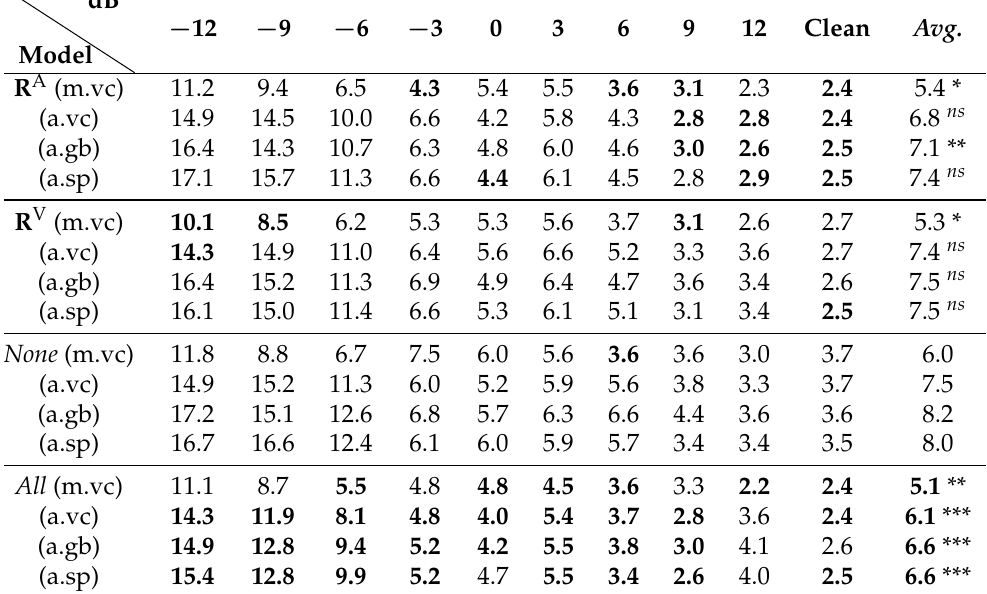
Table 10. Performance of the proposed E2E DFN fusion (WER [%]), based on the different E2E reliability indicator configurations. Among these, R A applies only audio-based reliability indicators and R V applies only video-based reliability indicators. None : proposed model without reliability information; All : use all reliability indicators. Other abbreviations as defined in Table 8. Avg : Average performance, together with the significance of improvements (compared with None ). ns :